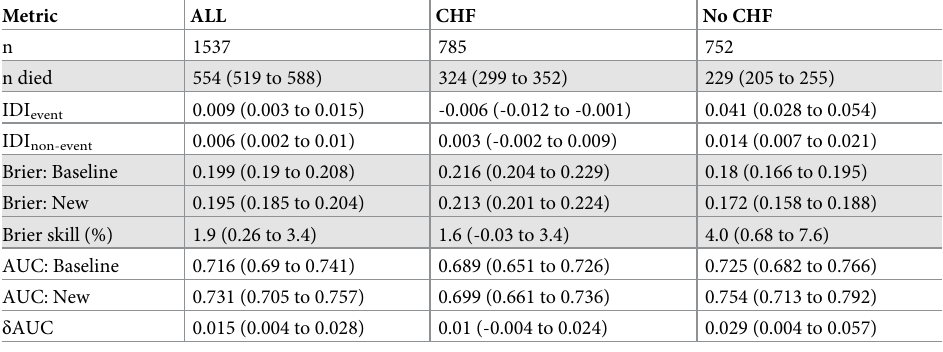
Table 2. Discrimination metrics for prediction of mortality. Metric ALL CHF No CHF n 1537 785 752 n died 554 (519 to 588) 324 (299 to 352) 229 (205 to 255) IDI event 0.009 (0.003 to 0.015) -0.006 (-0.012 to -0.001)